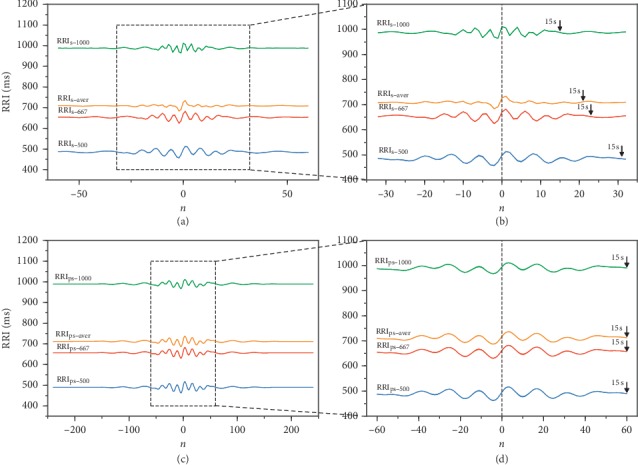
PRSA curves of synthetic RRI signals at three levels of RRI and average of all RRI signals. (a) PRSA curves of synthetic raw RRI signals. (b) Enlarged view of central oscillations in (a) with window of 15 s for RRIs-500. (c) PRSA curves of preprocessed synthetic RRI signals at resampling frequency of 4 Hz. (d) Enlarged view of central oscillations in (c) with window of 15 s for the three curves.